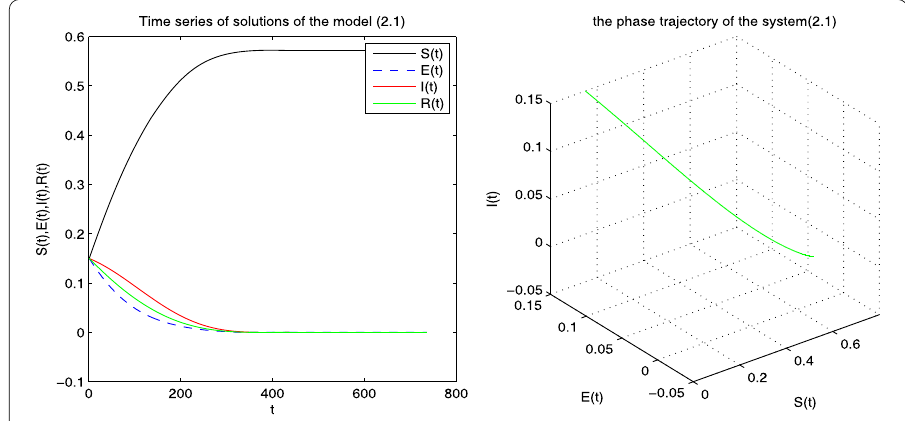
Figure 1 The disease-free equilibrium E 0 is globally asymptotically